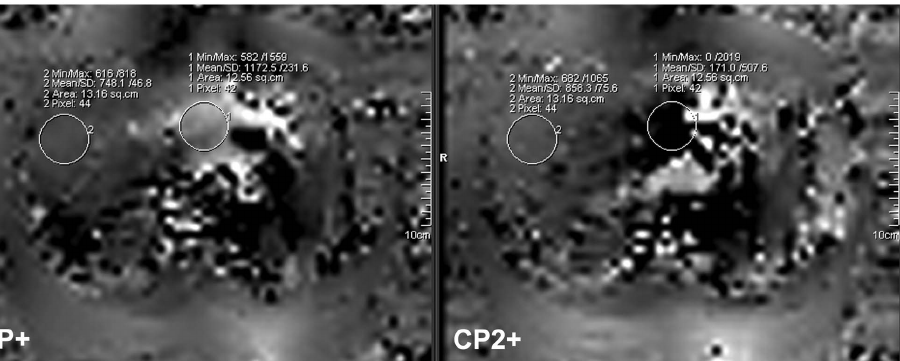
Figure 1. Flip angle maps obtained in two standard excitation modes in transversal orientation of the upper abdomen. Improved excitation of the liver is given with the CP 2 + mode compared to the CP + mode both in terms of general coverage, particularly of the right liver lobe as well as regarding mean reached flip angle. In the images, ROIs are displayed ventral of the aorta (ROI1) and within liver tissue of the right liver lobe (ROI2) yielding flip angle values encoded by a factor of 10.